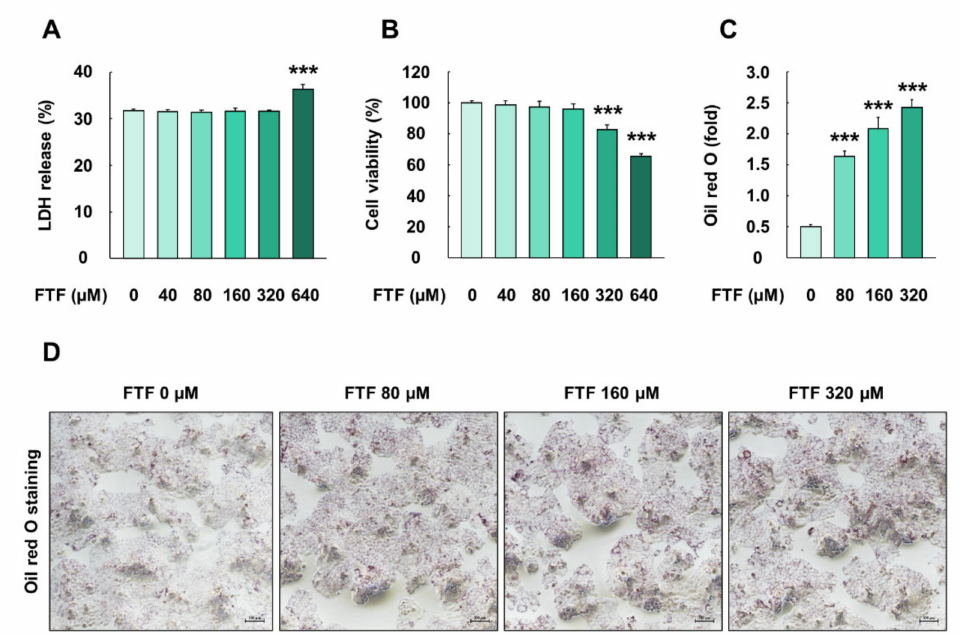
Figure 1. Effects of FTF on LDH release, cell viability, and lipid accumulation in HepG2 cells: ( A ) LDH release and ( B ) cell viability in HepG2 cells. The cells were treated with FTF (0, 40, 80, 160, 320, and 320 µ M for 24 h ( n = 3 wells per group); ( C ) quantification of red area and ( D ) Image in HepG2 cells stained with Oil red O The magnification of the image was 100 × . The cells were treated with FTF at the concentration of 80, 160, and 320 µ M for 24 h ( n = 3 wells per group). Images are representative of three independent experiments. The results are expressed as mean ± SEM and statistically significant difference, as compared to the control (DMSO), is indicated as *** P < 0.001. Abbreviations: FTF, flutriafol; LDH, lactate dehydrogenase; MTT, 3-(4,5-dimethylthiazole-2yl)-2,5-diphenyltetrazolium bromide; SEM, standard error of mean; DMSO, dimethyl